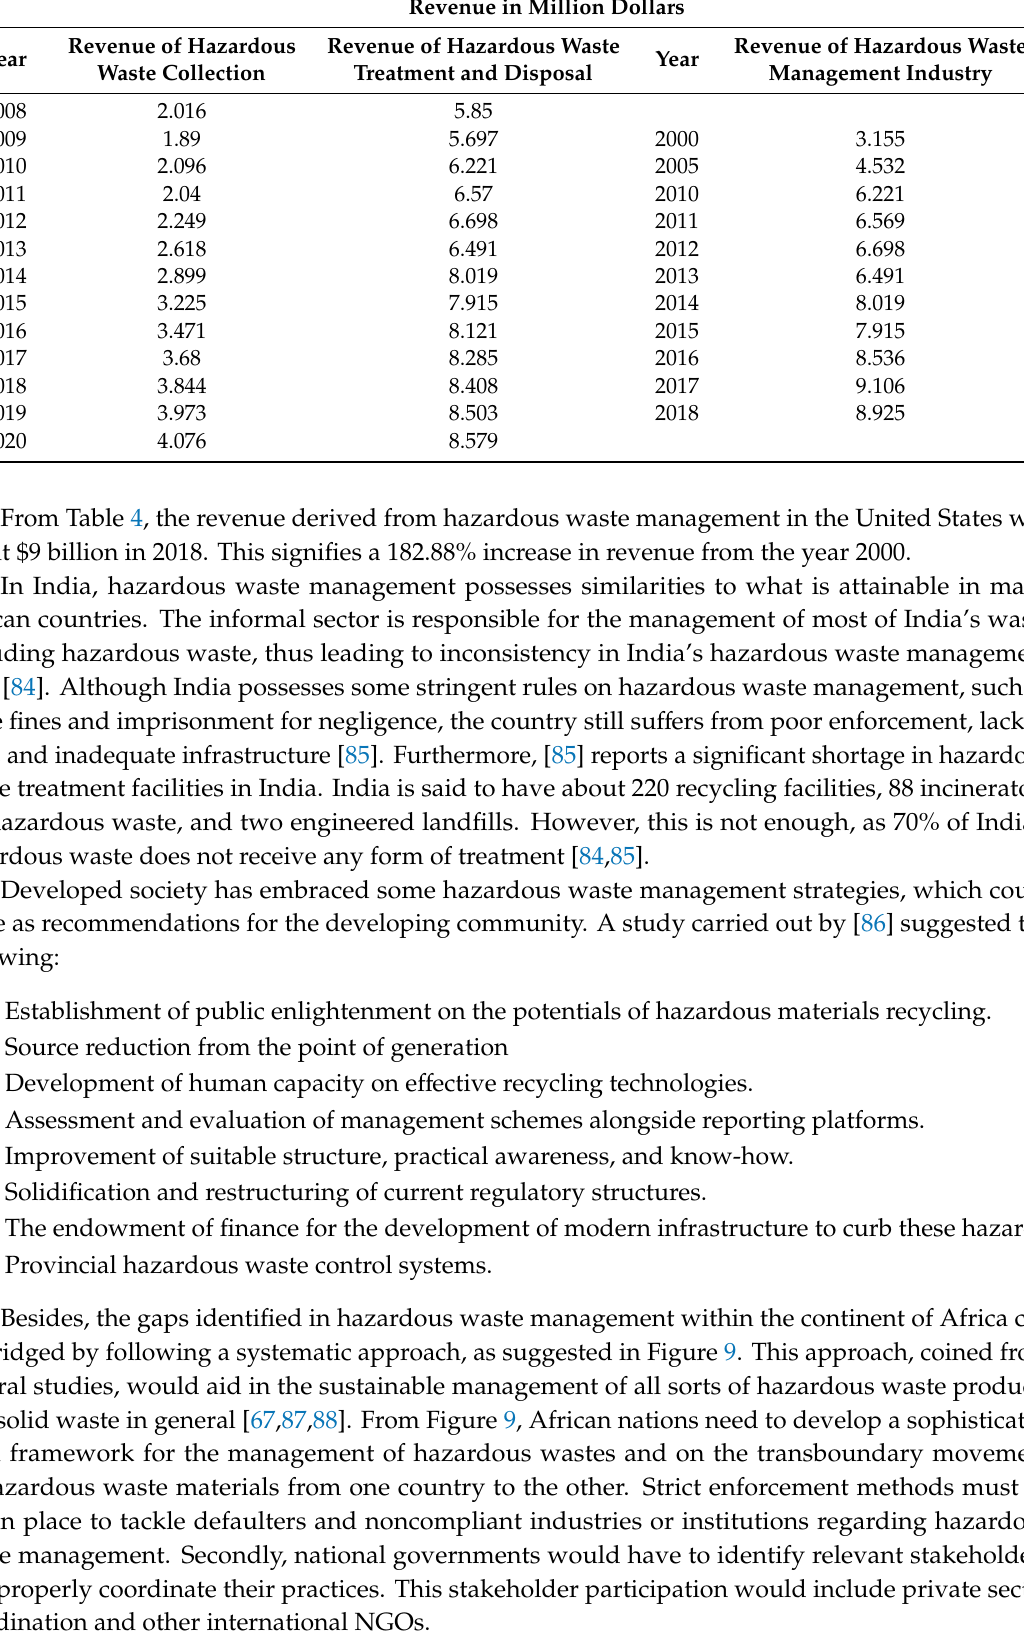
Table 4. Revenue for Hazardous Waste in the United States. Source: [83]. Revenue in Million